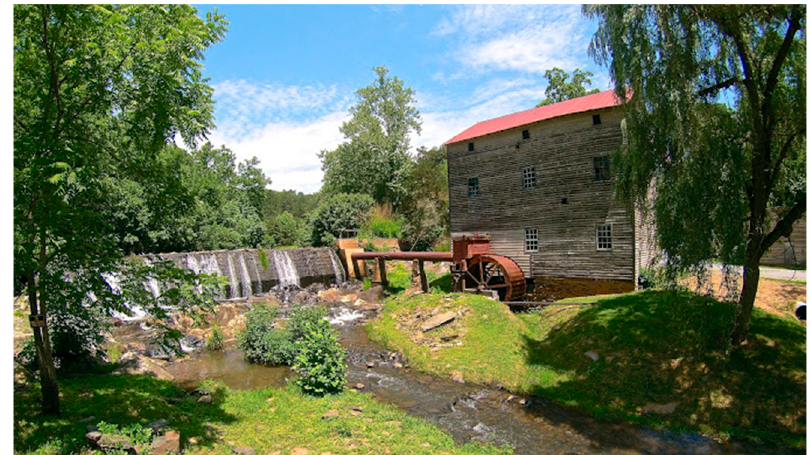
Figure 6. Historical content conveys deep meaning about past activities that have left a mark on the landscape. Activities that no longer exist may continue to bring images to mind. The ruins of the mill depicted in this photograph are reminiscent of the water wheel turning, the mill stone grinding, and sacks of grain being carried away to feed people and animals. Historical content does not have to be historic or connected to an important historic fact or event, although it could be. (Brightwells Mill by Bill Knarr Courtesy of Scenic Virginia).